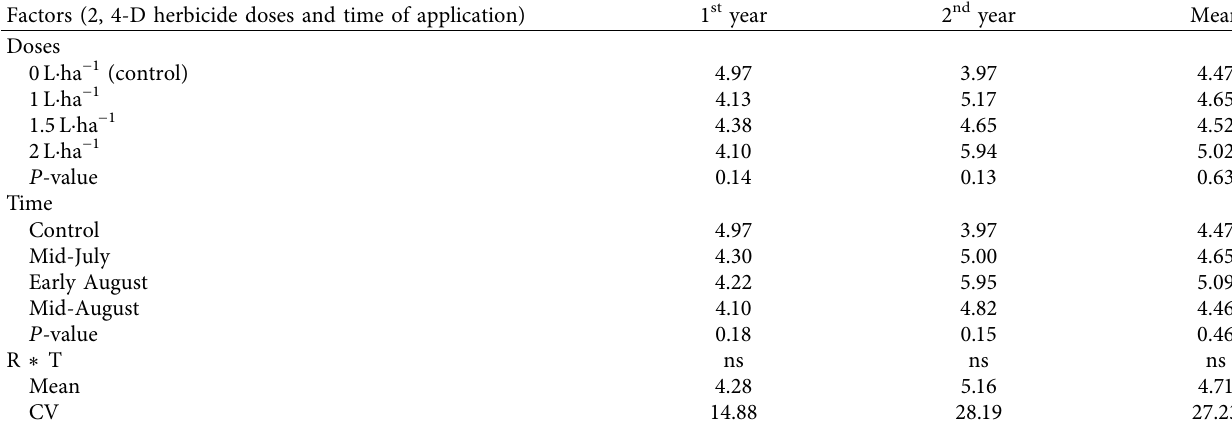
Table 11: Effect of doses, time, and their interaction of application of 2, 4-D herbicide on dry matter yield (t · ha − 1 ) of natural pasture forage portions.